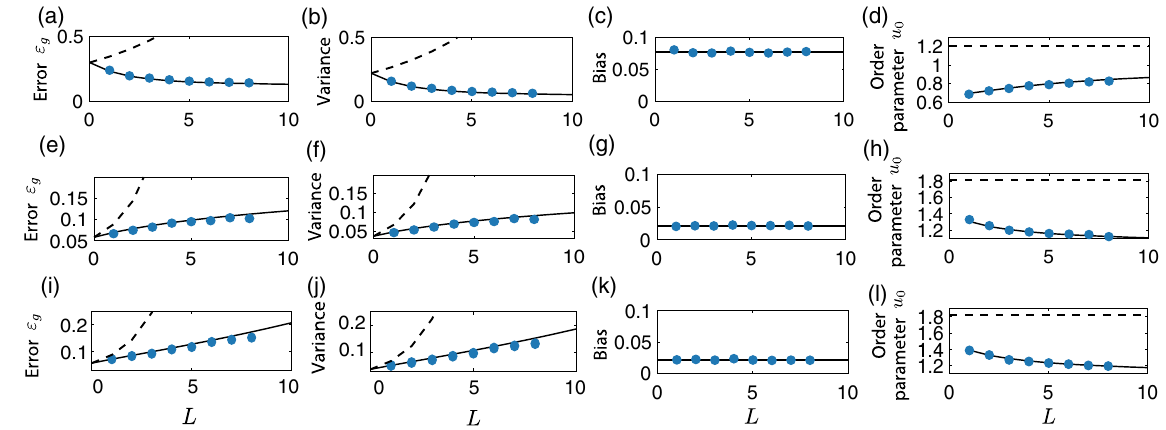
FIG. 4. Dependence of the generalization error on network depth L . (a,e,i) Generalization error, (b,f,j) variance, (c,g,k) bias of the predictor, and (d,h,l) order parameter u 0 as a function of L . Black solid lines: theory. Blue dots: simulation. Black dashed lines: GP limit ( N → ∞ ). (Details of the example model and parameters are described in Appendix E.) (a) – (d) Subregime where the generalization error decreases with L . (e) – (h) Subregime where the generalization error increases with L approaching a finite limit. (i) – (l) High-noise regime where the generalization error increases with L and diverges as L → ∞ .